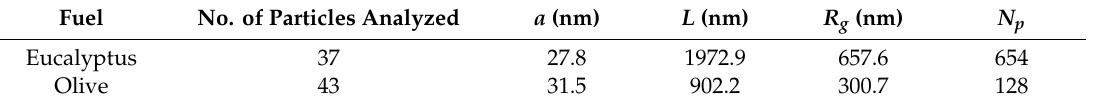
Table 1. Input data from images of filter samples from eucalyptus and olive fuels.